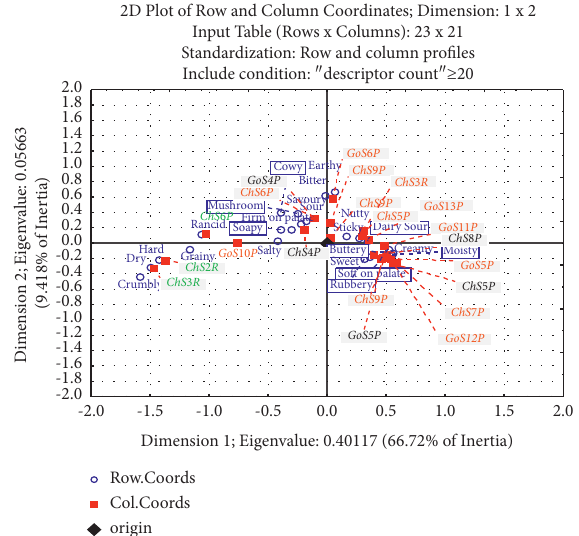
Figure 4: Representation of samples with texture and flavor sensory attributes in the first two dimensions of the CA plot performed on data from sorting of the “Cheddar-Gouda” group ( n � 21). For cheese codes, the Ch refers to Cheddar and Go refers to Gouda, S1 to S15 refer to the supplier, and P (pasteurized) and R (raw) refer to the milk type. Color codes: black: 1 month; orange: 3 months; green: 6 months.